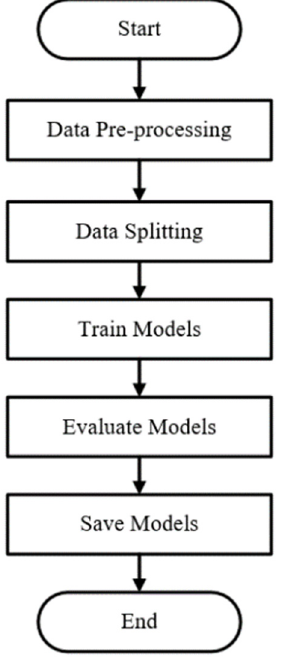
Figure 10. Model training process.